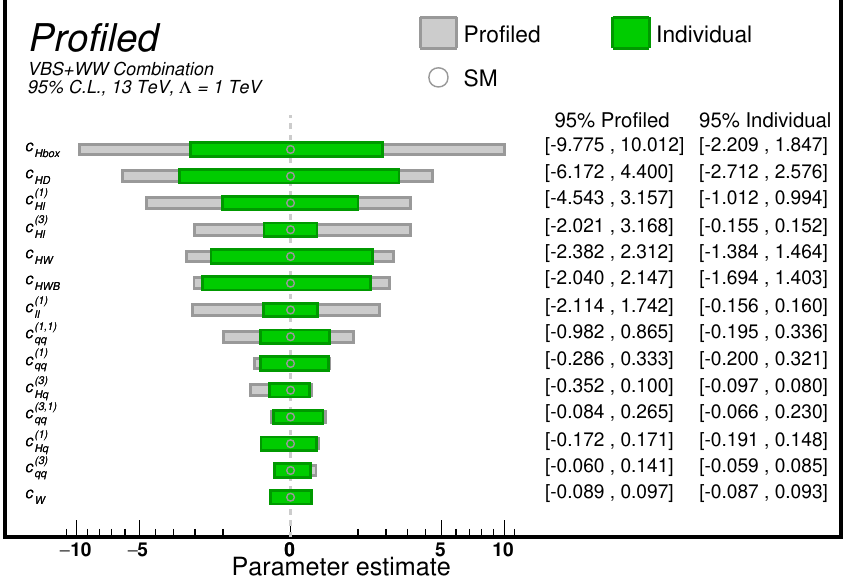
Figure 7 . Sensitivity of the combined analysis of VBS SSWW+2j, OSWW+2j, WZ+2j, ZZ+2j and diboson WW to the dimension-six operators considered, when the remaining Wilson coefficients are set to zero (green) or profiled away (grey). The QCD-induced EFT dependence was included where